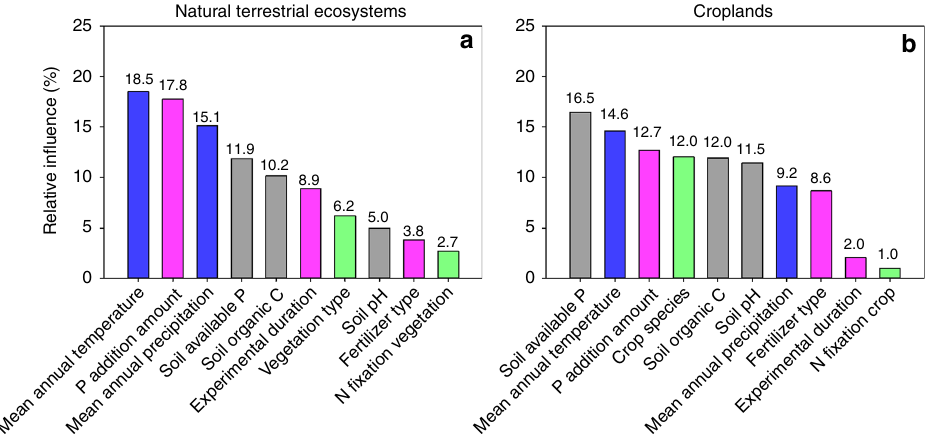
Fig. 4 Relative in fl uence of climate, fertilization regimes, and ecosystem properties on the magnitude of P limitation. a Natural terrestrial ecosystems. b Croplands. The number above each bar indicates the percentage of the total explained variation accounted for by the variable. Fertilization regimes are in pink, climate factors are in blue, soil properties are in gray, and vegetation properties are in green. Source data are provided as a Source Data fi